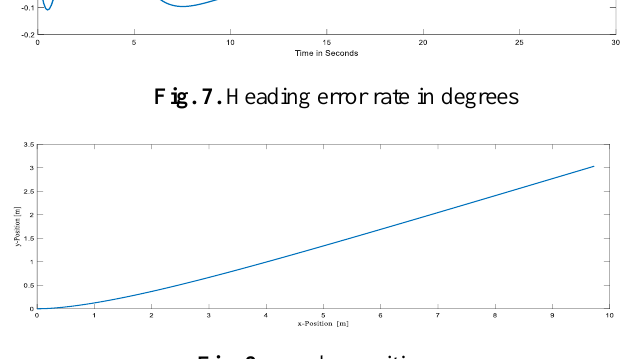
Fig. 7. Heading error rate in degrees